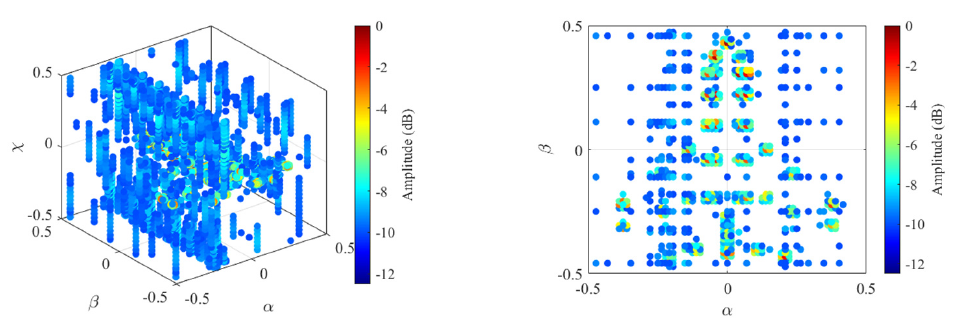
Figure 11. Target imaging result obtained by the 3D IFFT in the presence of WBI with ISR = 70 dB.